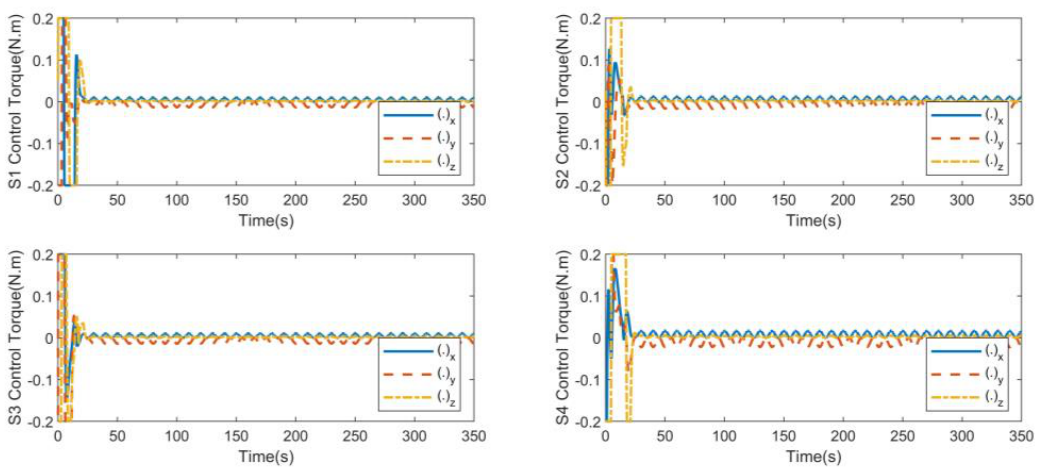
Figure 8. S1, S2, S3, S4 control torque for non-consistent collaborative control. Case 2: Verify the performance of hierarchical saturated consistent collaborative controller under time-varying delay and switching